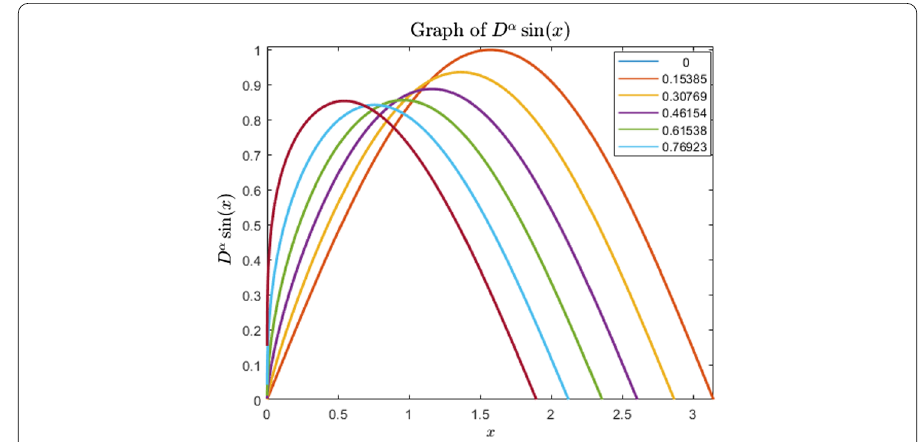
Figure 2 The graph of D α sin( x ), where D α is the Riemann–Liouville fractional